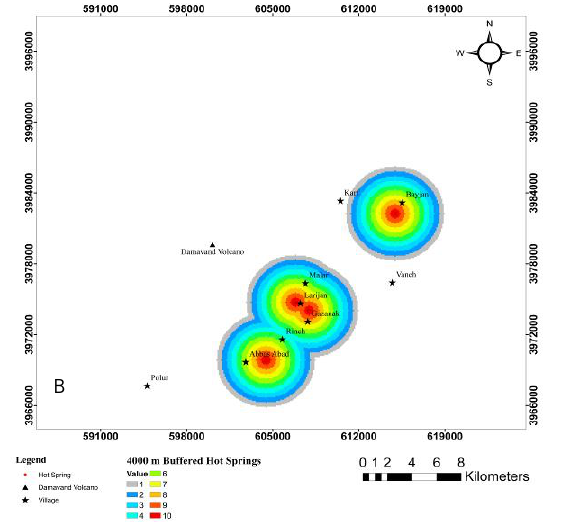
Figure 4. Hot Springs Factor Classified map, after 4000 m